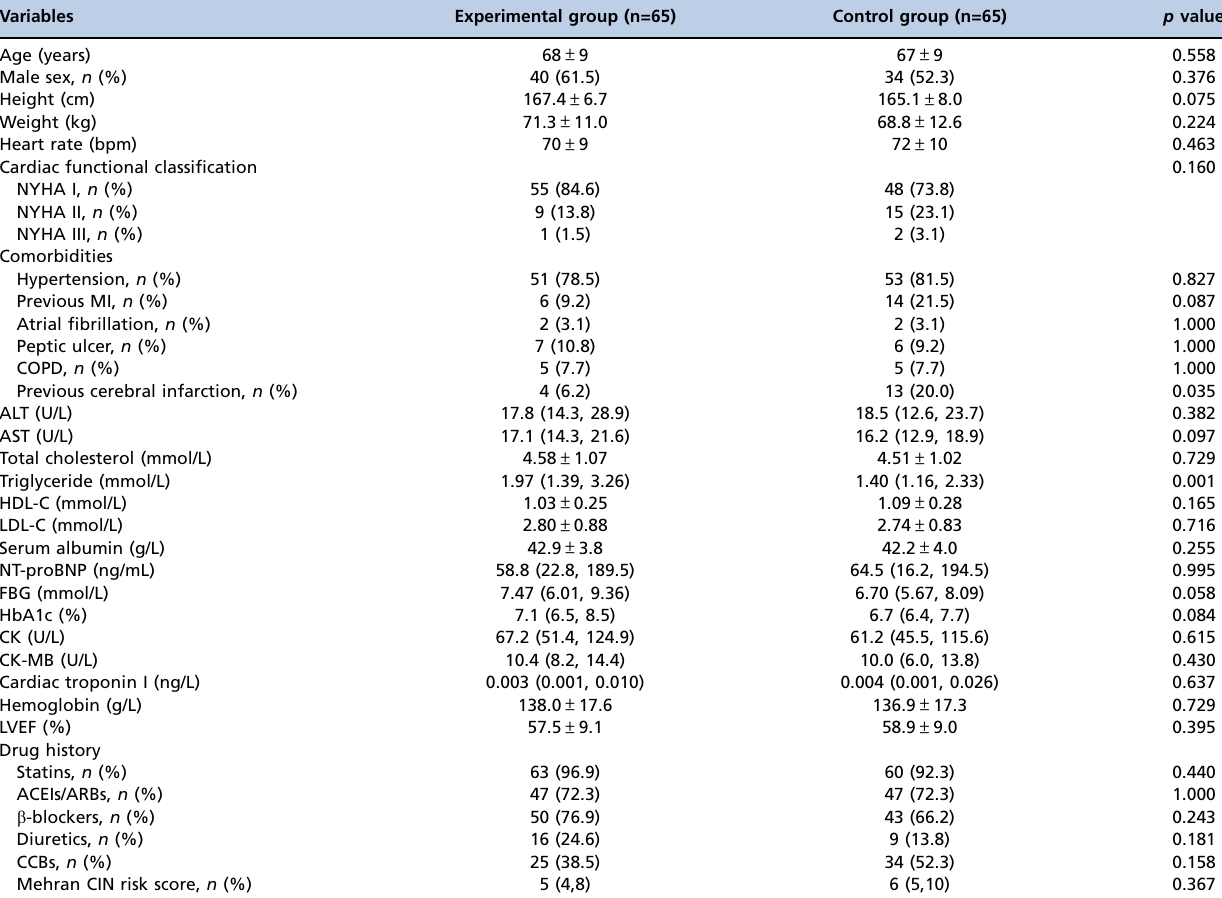
Table 1 - Baseline clinical characteristics of the patients.